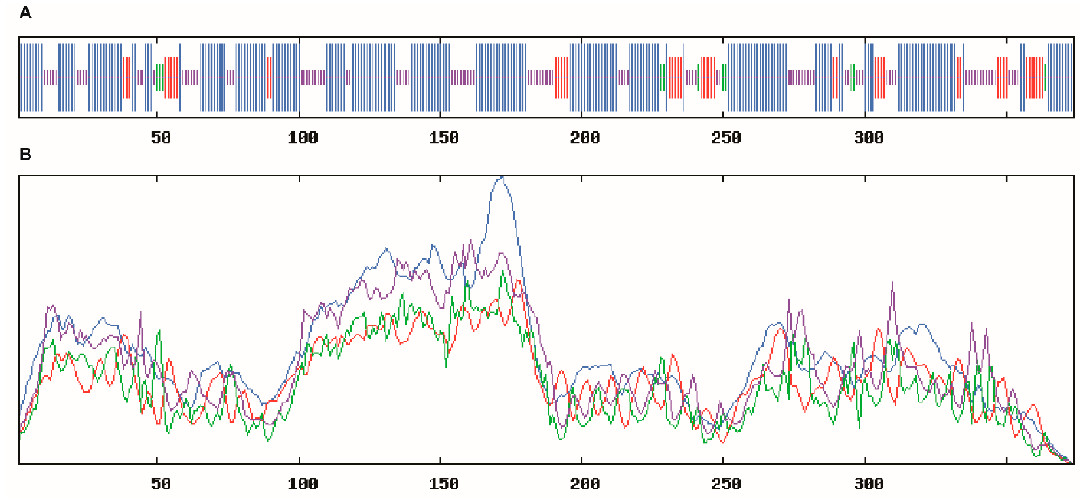
Figure 3. Secondary structural analysis of the BcHHP5 Protein. ( A ) Comparison of the secondary structures of BcHHP5 protein; ( B ) helix, turn, strand, and coil were represented with blue, red, green, and purple lines, respectively.